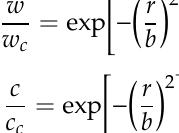
Figure 8. Comparison between numerical results and experimental results.